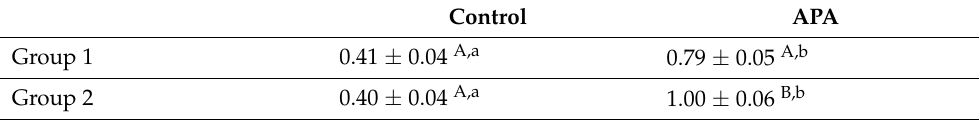
Uppercase letters indicate differences between material groups, and lowercase letters indicate differences between surface treatment